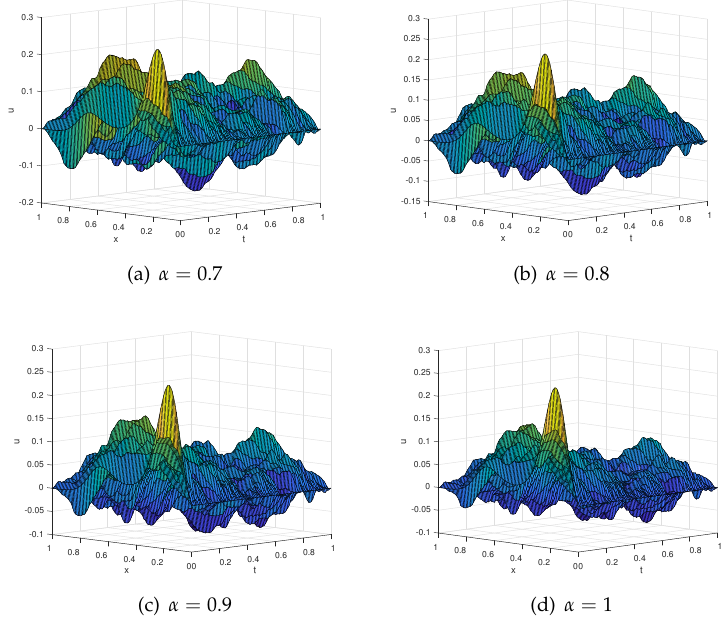
Figure 6. The approximation solutions of Example 2 (case (2)) with σ = 1.